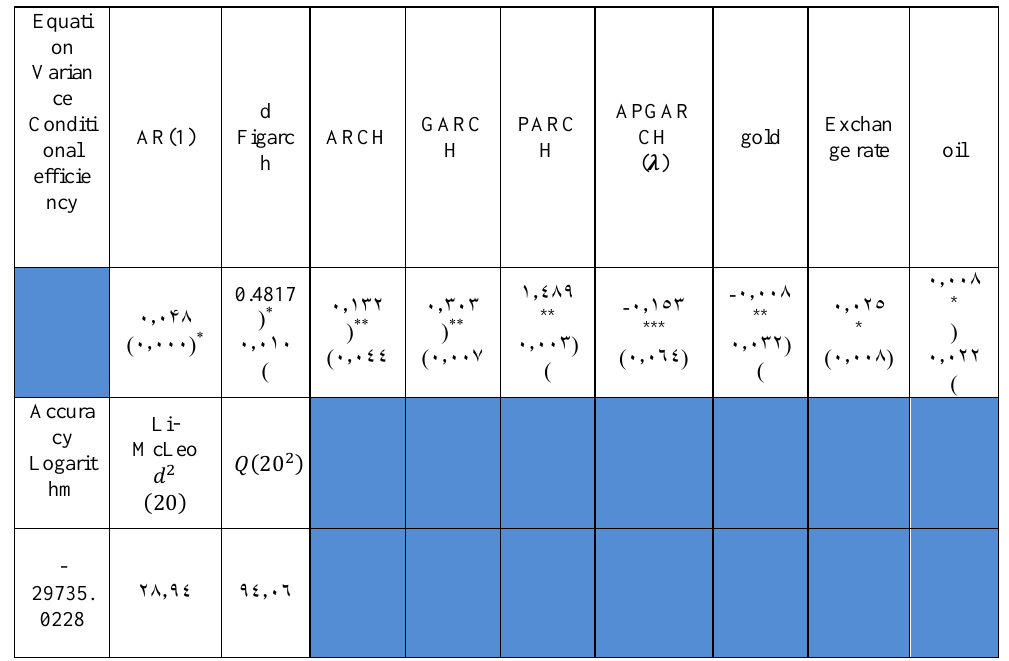
Table 2. Estimation of ARMA (1, 0) –FIAPARCH-X (1, d, 1) Model for efficiency